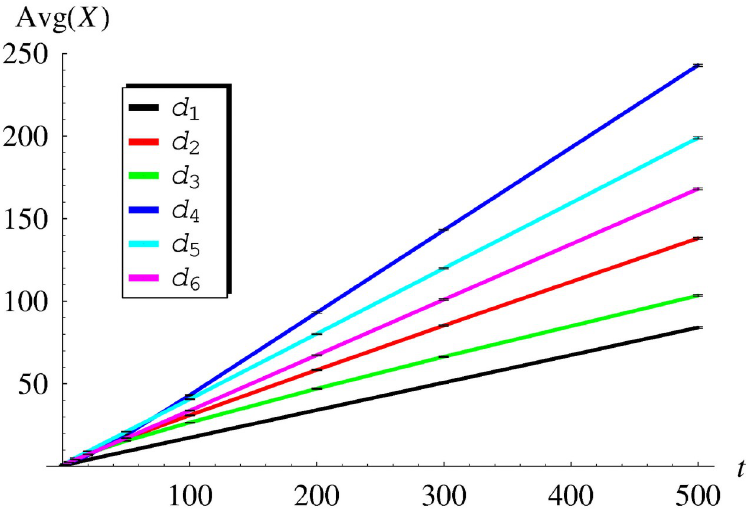
Fig 1. The average queue size versus time for dropping functions d 1 − d 6 . The confidence intervals for the confidence level of 0.99 are shorter than the line width.